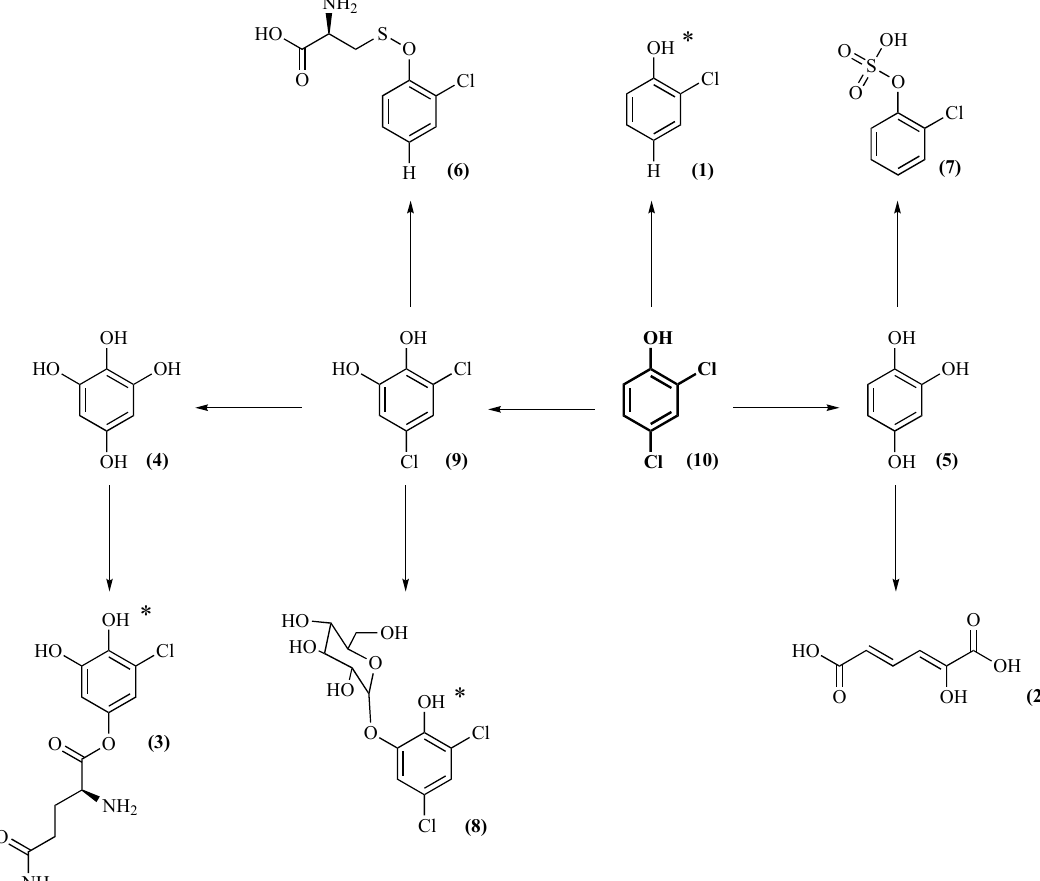
Figure 2. Proposed metabolic pathway for the detoxification of 2,4-DCP by the isolated fungi. The isomers were suggested according to MS and literature data. For the metabolites where there is no information about the most probable isomer, an asterisk was added next to the molecule. The number next to each compound is that corresponding to Table 2.